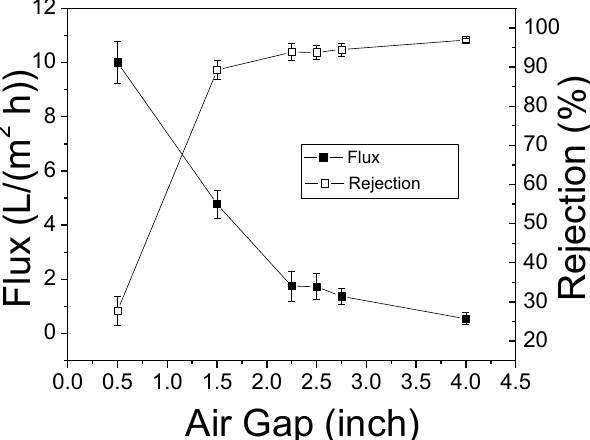
Figure 8. Desalination performance of PBI HF varied with air gap (test condition: 2000 ppm NaCl, 300 psi, and 25 ± 2 °C).